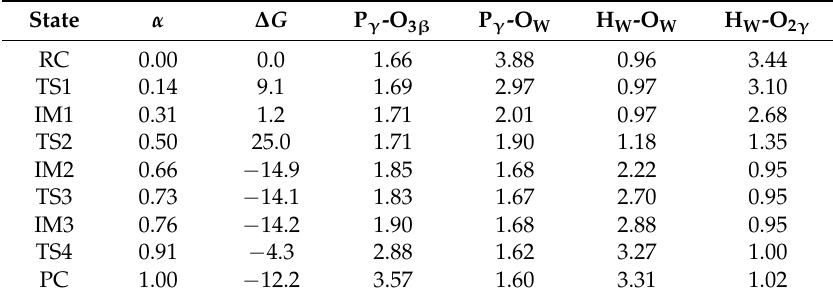
Table 2. Free energies (in kcal/mol) and collective variables (in Å) of the stationary states on the MFEP obtained for the SAC